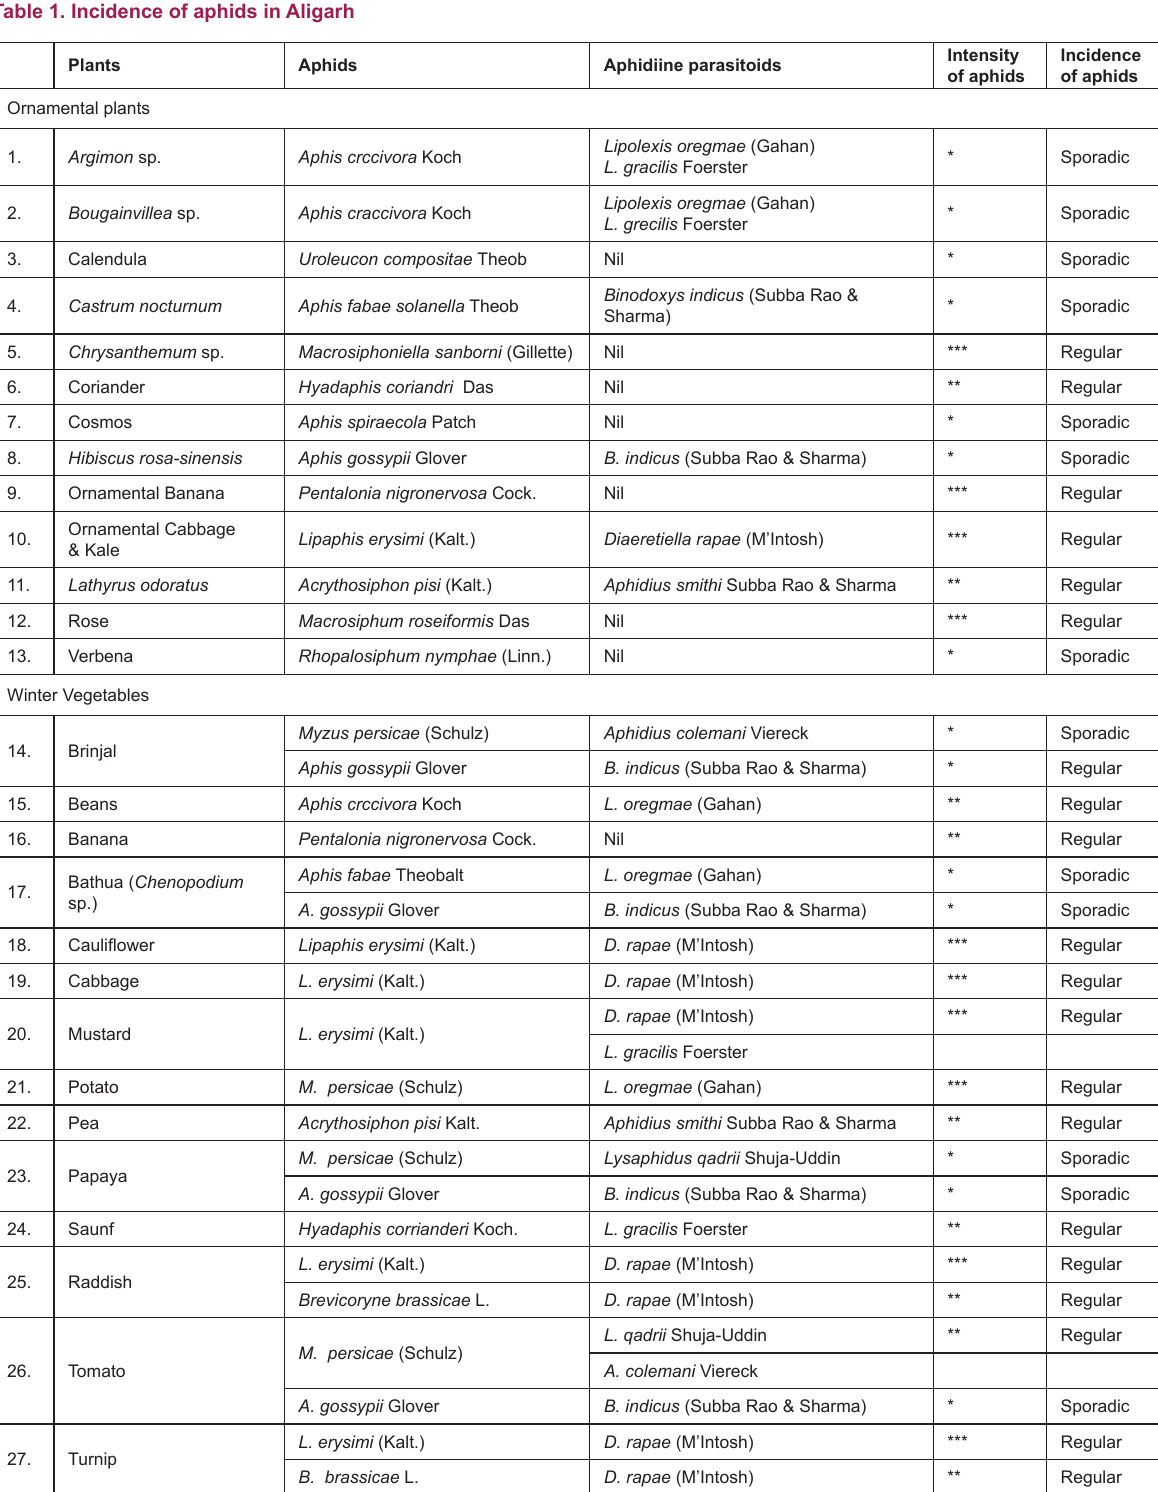
Table 1. Incidence of aphids in